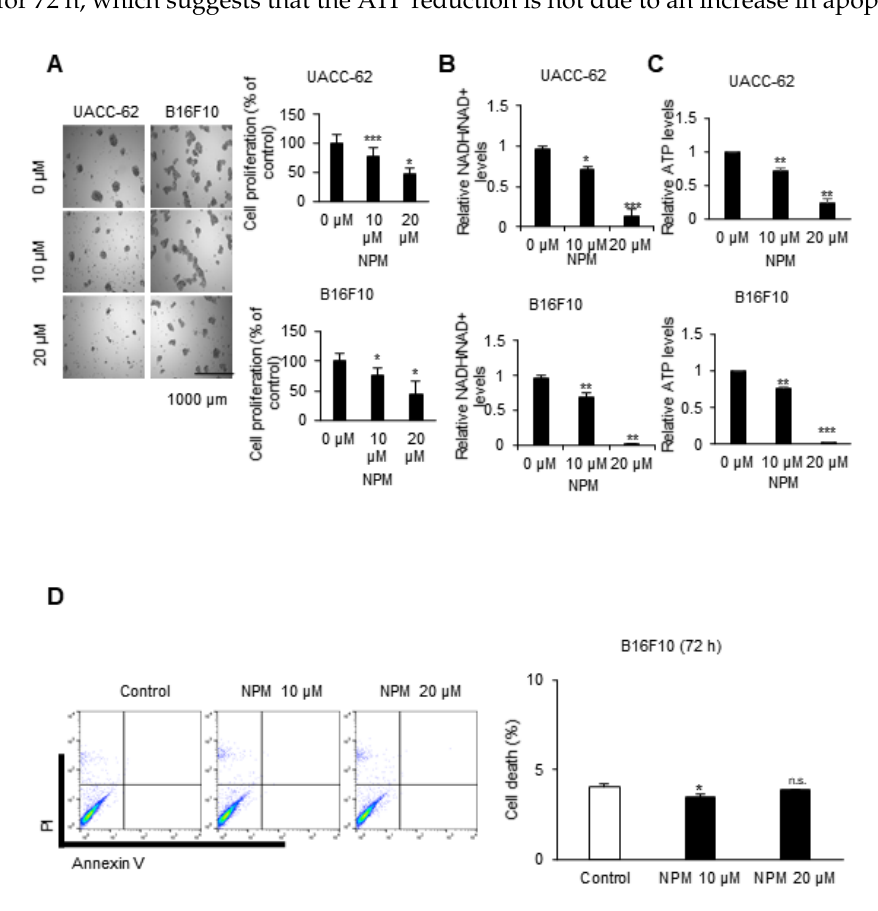
Figure 3. Cancer cell proliferation was regulated by NPM. ( A ) Cancer cell proliferation was determined by SRB assay in UACC-62 and B16F10 TSs treated with the indicated concentration of NPM for 72 h. ( B ) The NADH/NAD+ ratio was measured in UACC-62 and B16F10 cells treated with the indicated concentration of NPM for 72 h. ( C ) The ATP level was measured using luminescent ATP assay kit in UACC-62 and B16F10 cells following to the treatment of NPM for 72 h. ( D ) Cell death was determined by annexin V and propidium iodide (PI) staining in B16F10 cells treated with 10 and 20 μ M NPM for 72 h. Data represent the mean and standard deviation of three independent experiments. * p < 0.05, ** p < 0.01, and *** p < 0.001 compared with the vehicle control.